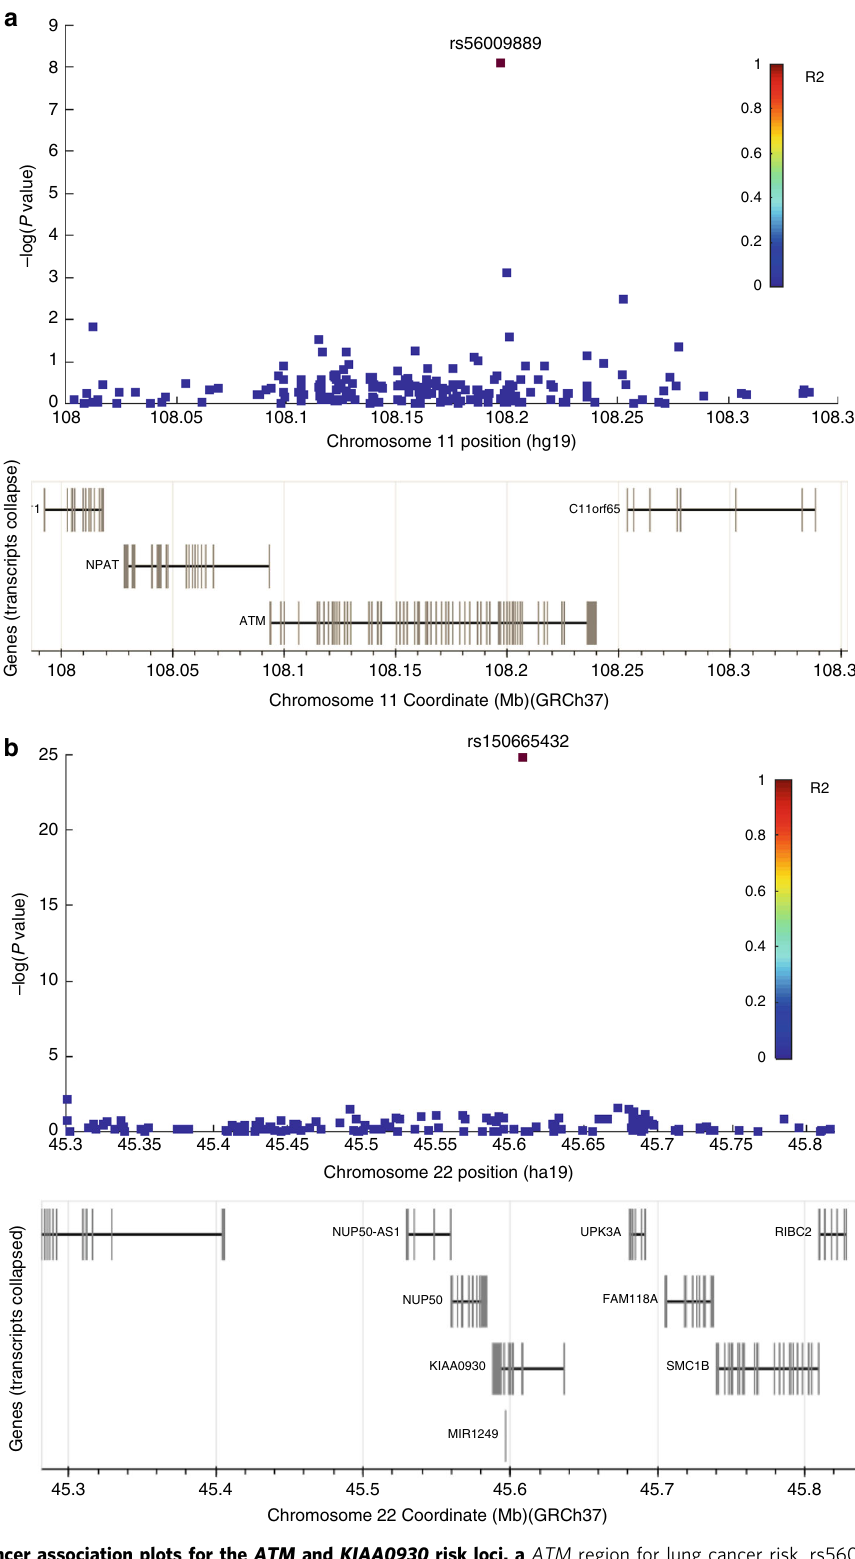
Fig. 1 Regional lung cancer association plots for the ATM and KIAA0930 risk loci. a ATM region for lung cancer risk. rs56009889, localizing to chromosome 11 and mapping within ATM , is not in linkage disequilibrium (LD) with any SNPs that have been identi fi ed before; b KIAA0930 region for lung cancer risk. rs150665432 localizes to chromosome 22 and maps within uncharacterized KIAA0930 , which is not in LD with any SNPs that have been identi fi ed before. For each plot, − log 10 P values (y-axis) of the SNPs are shown according to their chromosomal positions ( x -axis). The top genotyped SNP in each analysis is labeled by its rs number. The color intensity of each symbol re fl ects the extent of LD with the top lung cancer-associated SNP in the discovery data: blue ( r 2 = 0) through to red ( r 2 = 1.0). Physical positions are based on NCBI build 37 of the human genome. The relative positions of genes are also shown. Source data are provided as a Source Data fi le (Source Data